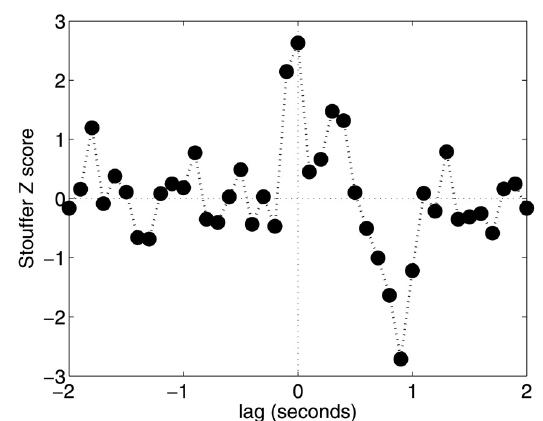
Figure 1. Time-synchrony analysis. Positive lags in this graph represent post-stimulus S-R correlations; negative lags are pre-